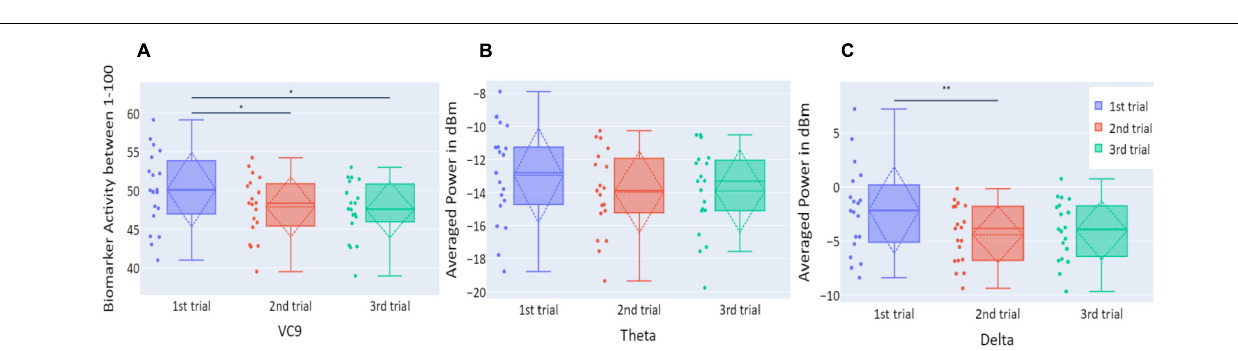
FIGURE 3 | (A) The distribution of participant VC9 activity (normalized between 1 and 100); (B) the distribution of theta (averaged power of 4–7 Hz in dBm); and (C) the distribution of delta (averaged power of 0.5–4 Hz in dBm), obtained in the three trials of Experiment 1, as a function of task repetitions: first trial (blue), second trial (red), and third trial (green), for all participants ( n = 19). Dashed lines represent means and SDs. ∗ p < 0.05, ∗∗ p < 0.01, and ∗∗∗ p <